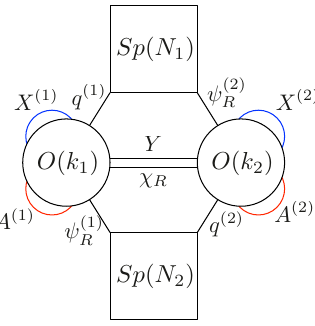
(cid:2) Sp( N 1 ) 2 ) with a bi-fundamental hypermultiplet.